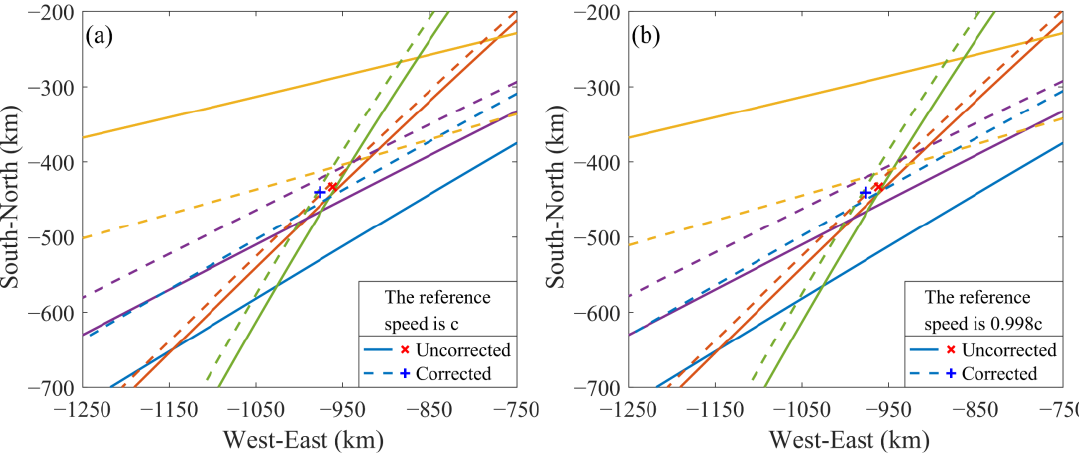
Figure 6. Same as Figure 5, but for the signals shown in Figure 2. ( a ) Compensating the peak time delay with a reference speed of 𝑐 . ( b ) Compensating the peak time delay with a reference speed of 0.998 𝑐 .